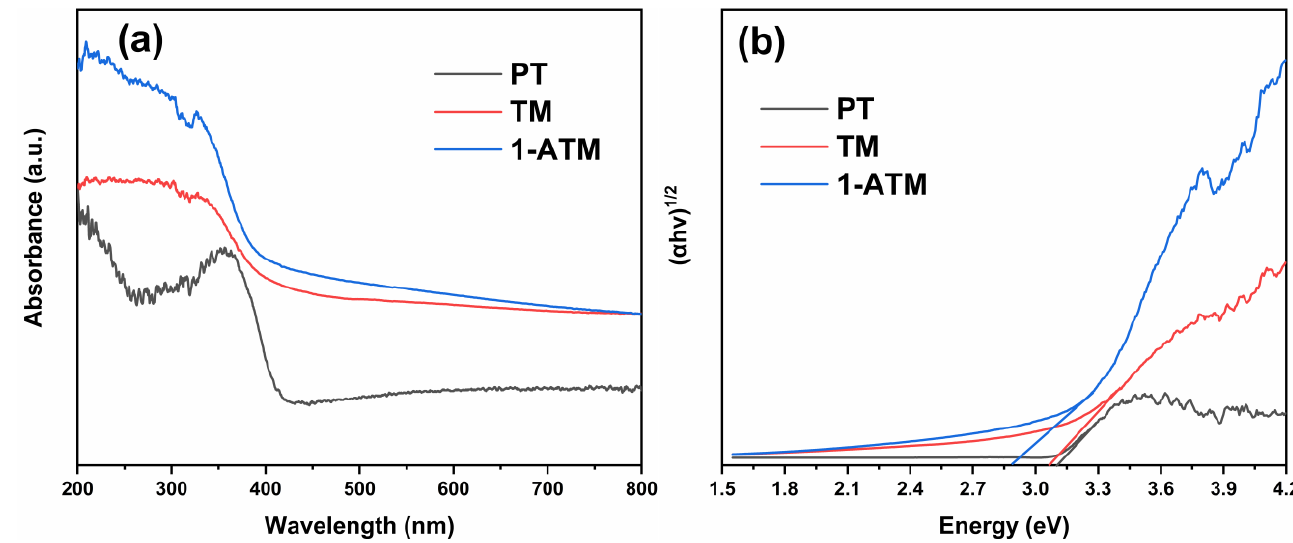
Figure 8. UV–visible absorption spectra ( a ) and band gap ( b ) of PT, TM and 1-ATM.